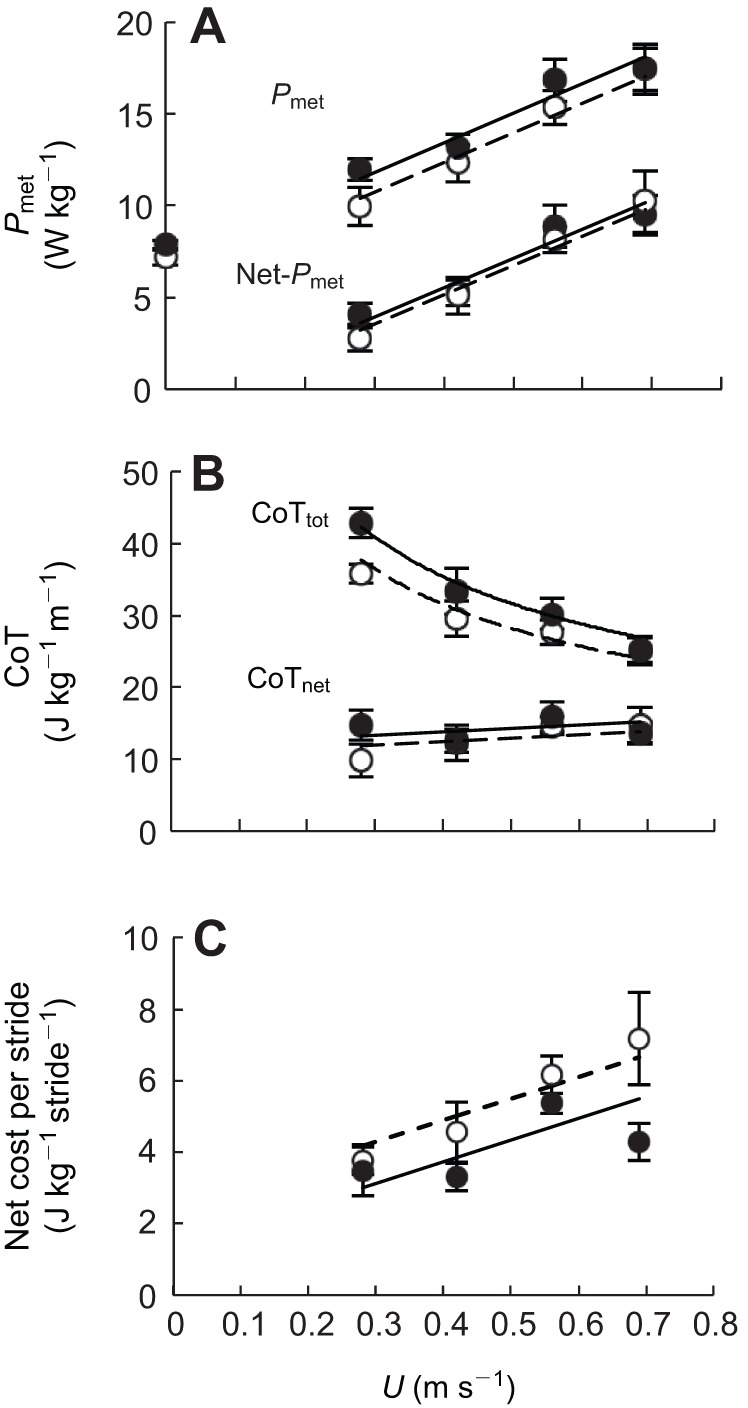
Relationships between mass-specific energetic parameters and walking speed. Data points and best-fit lines are as in Fig. 1. The lines of best fit are (A) metabolic power, Pmet=16.20U+6.93 (bantam) and 16.20U+5.86 (large); and net metabolic power, net-Pmet=16.00U−0.88 (bantam) and 16.00U−1.26 (large); (B) total cost of transport, CoTtot=22.39U−0.50 (bantam) and 19.95U−0.50 (large); and net cost of transport, CoTnet=4.77U+11.89 (bantam) and 4.77U+10.53 (large); and (C) net cost per stride=7.10U+2.42 (bantam) and 21.21U+0.24 (large). Mass-specific resting (standing) metabolic rates are also included in A at 0 m s−1. Data points are means±s.e.m.